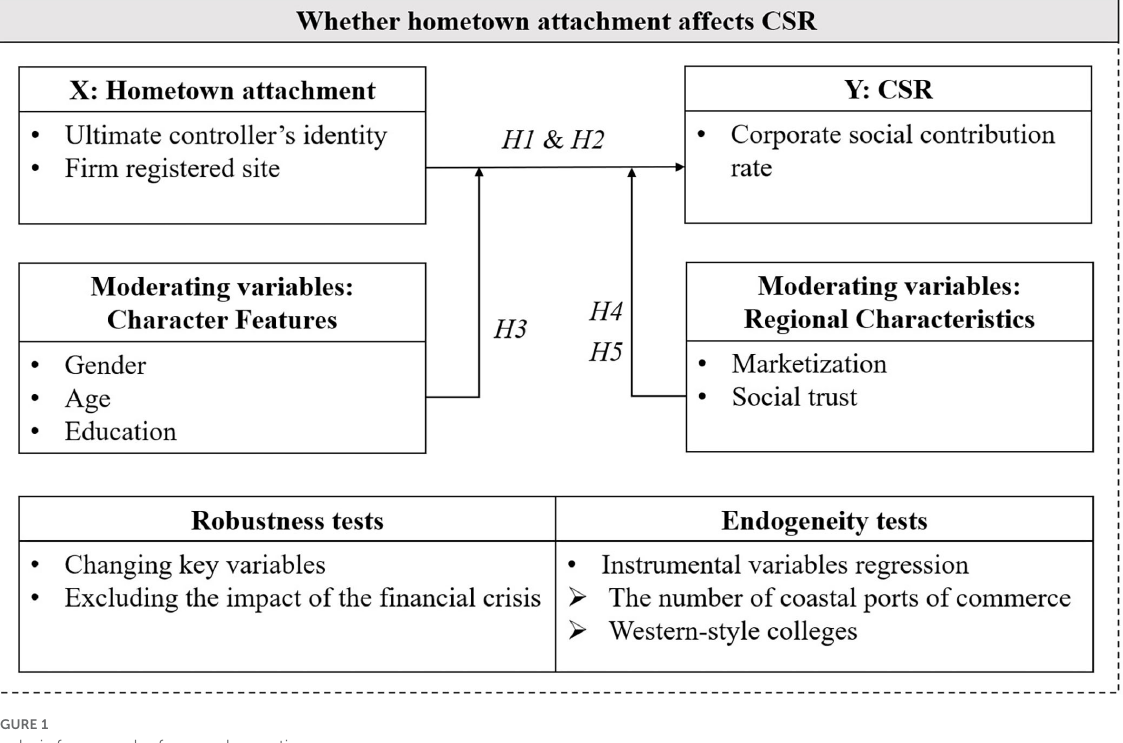
FIGURE1 Analysis framework of research